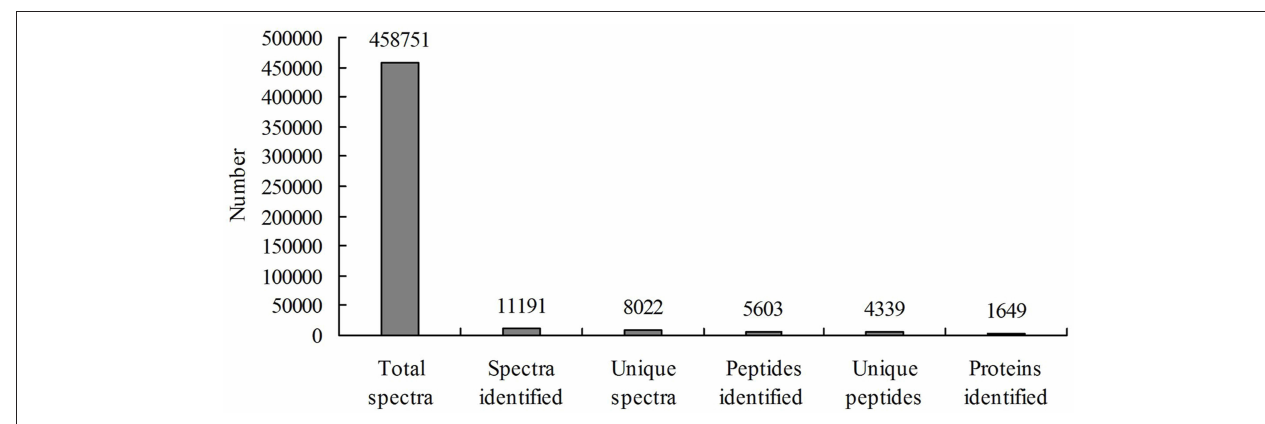
FIGURE 1 | Spectra, peptides and proteins identified from iTRAQ proteomics after searching against the sequence databases.